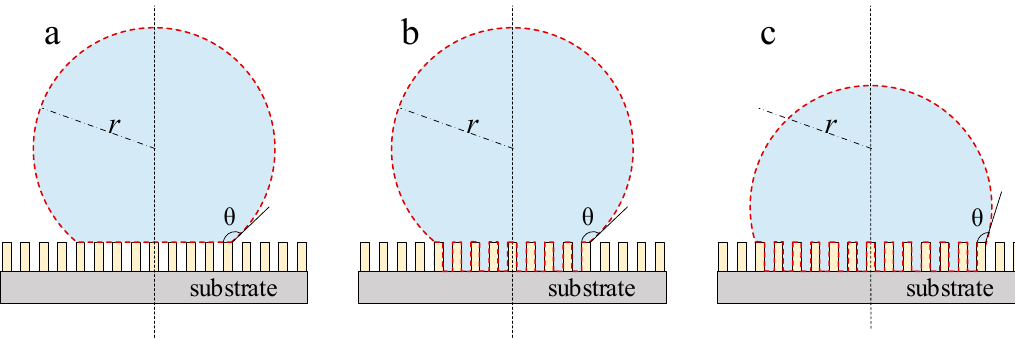
Figure 4. The state of droplets on the surface of the micro-nano structure: ( a ) Cassie state; ( b ) Partial Wenzel; ( c ) Wenzel state.